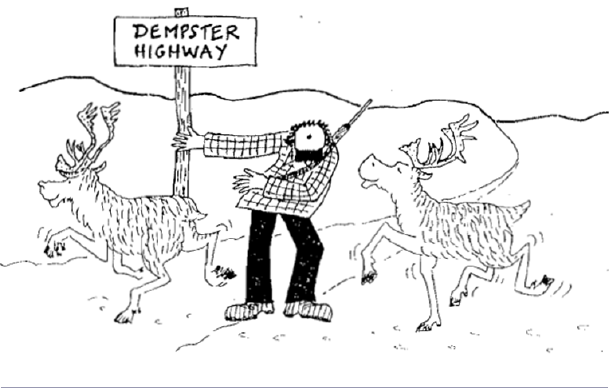
Fig. 1 . Cartoon used by the Porcupine Caribou Management Board (PCMB) to illustrate the “Let the leaders pass” hunting regulation. Cartoon by D. Urquart, who served as the PCMB Secretary at that